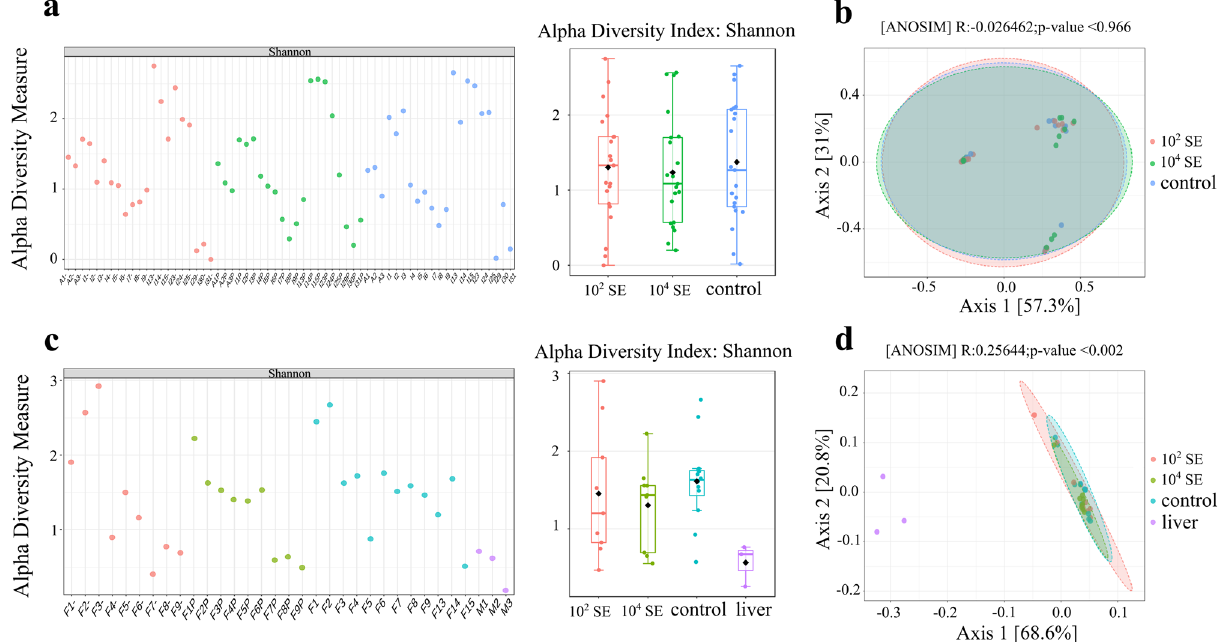
Figure 8. Alpha diversity represented by the Shannon’s diversity index for: ( a ) insect associate samples; and ( b ) liver associated samples. PCoA based on weighted UniFrac distances for ( c ) insect; and ( d ) liver